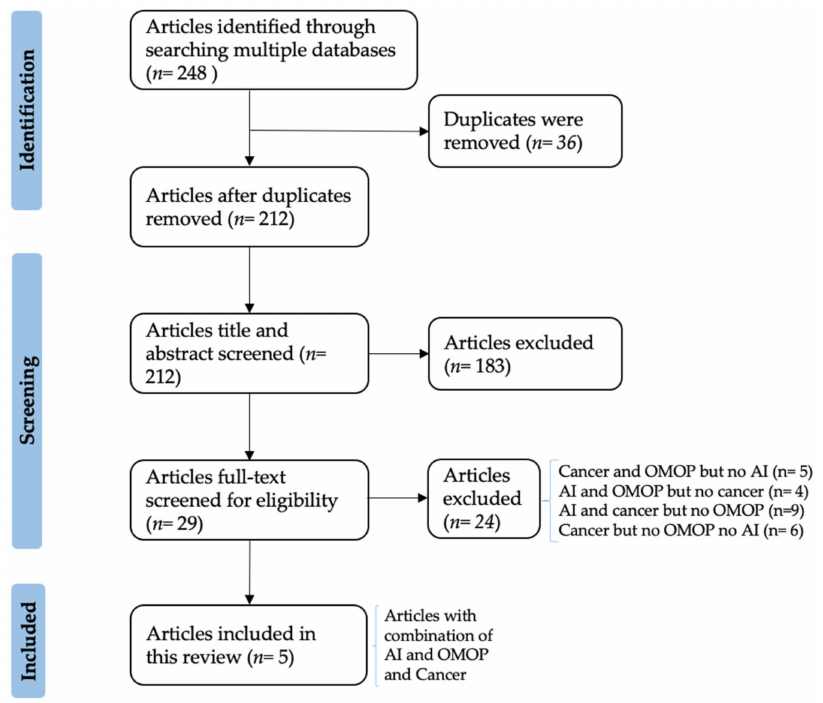
Figure 1. PRISMA Flow-chart diagram showing the paper selection